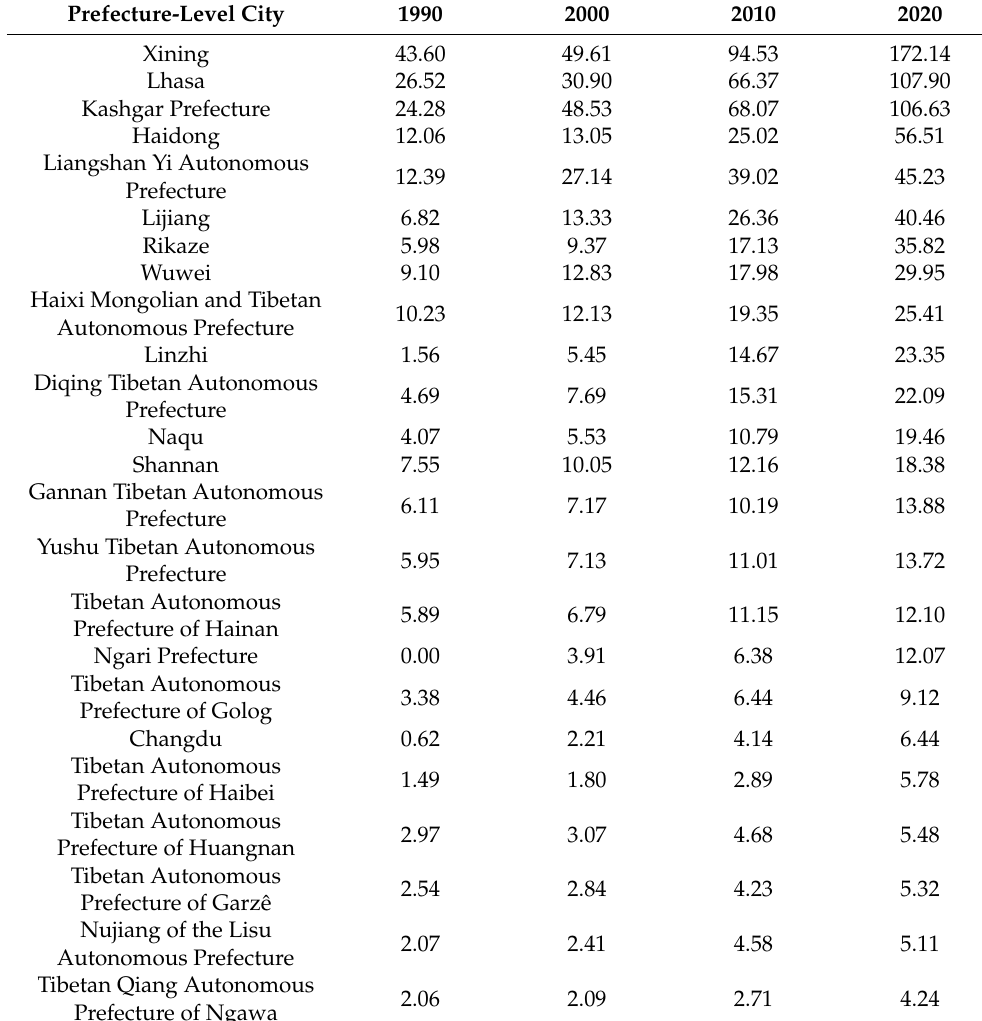
Table 1. Areas of urban land use at the prefecture level in the Qinghai–Tibet Plateau during 1990–2020 (km 2